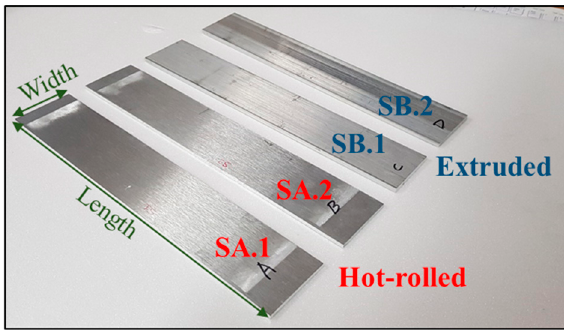
Figure 6. Aluminum plate specimens used in experiments.